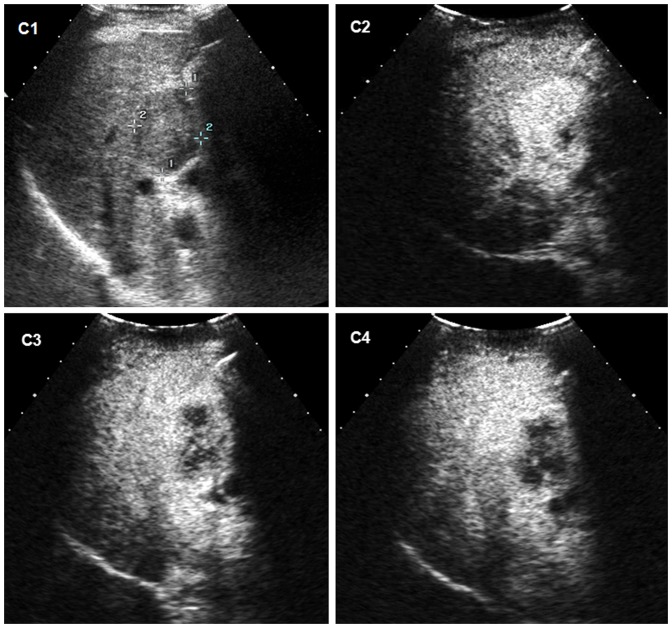
Intrahepatic cholangiocellular carcinoma (ICC) in a 42-year old man with cirrhosis. C1Conventional ultrasound shows a hypoechoic nodule of 46-out appearance 48 seconds after injection of contrast agent. C4 The lesion appears as marked wash-out 91 seconds after the administration of contrast agent.